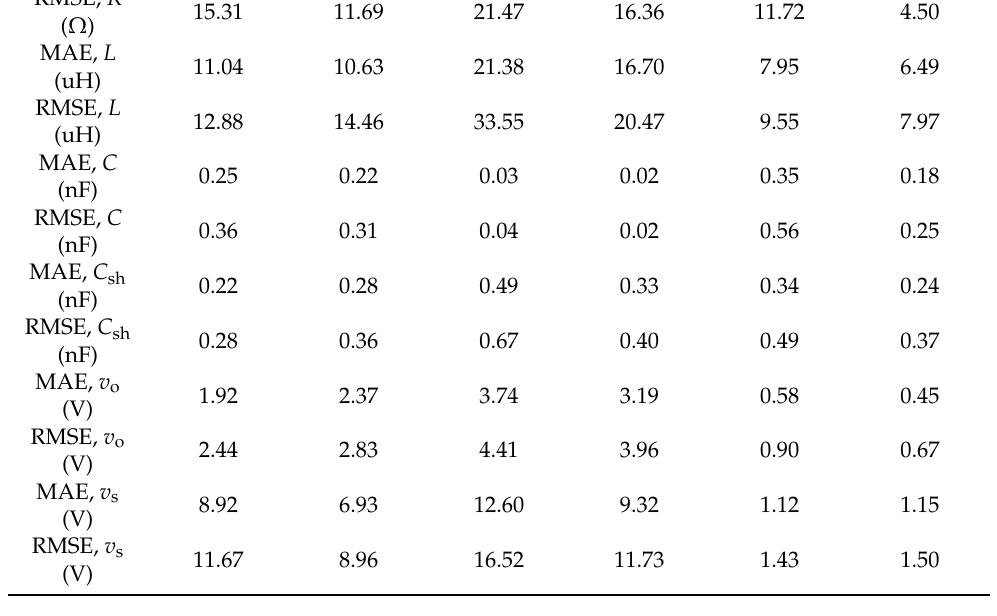
Table 4. Summary of the results of the initial hybrid ANN ‐ optimization networks.